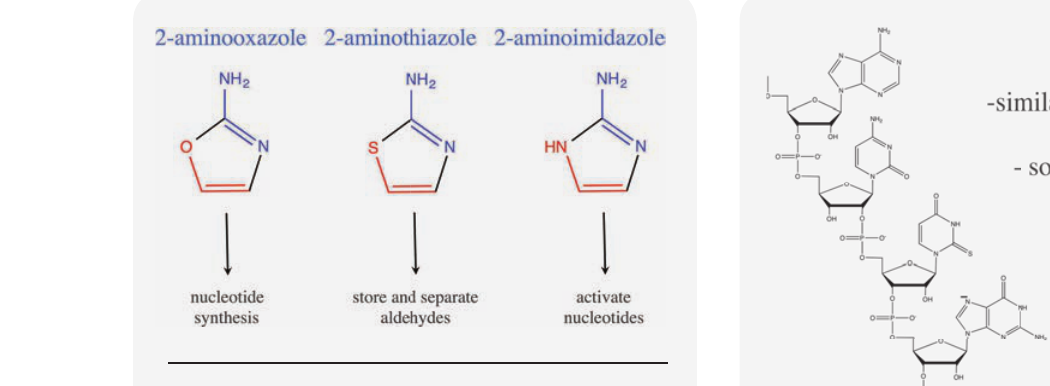
Figure 10. Common origins and complementary functions of three closely related heterocycles. 2AO (left) is a precursor of nucleotides, 2AT (center) can store simple sugars as crystalline complexes, and 2AI (left) activates nucleotides for polymerization. All three compounds can be made in the same or very similar conditions. Figure 11. What was the primordial genetic polymer? The illustrated